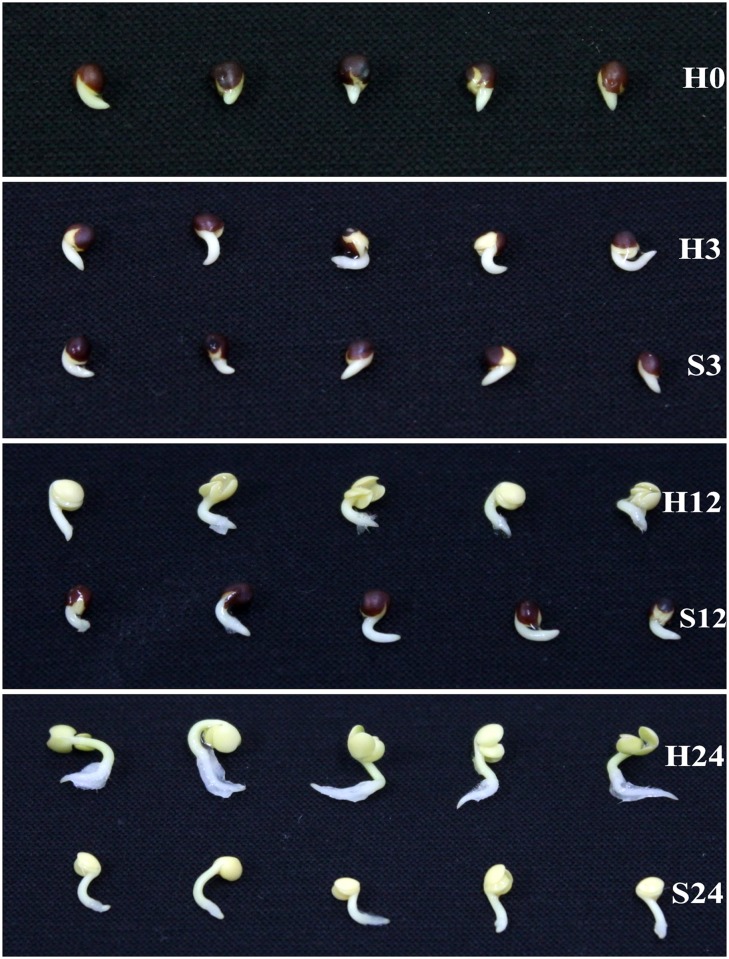
Phenotypes of germinated seeds of Brassica napus line WH126 at 0, 3, 12 and 24 hours after H2O (control) and salt (1.25% NaCl) treatments.The names on the figure refer to the corresponding rows of germinated seeds. H indicates H2O treatment, S indicates salt treatment and the adjacent numbers indicate the sampling time points. The names were also used to describe the corresponding cDNA libraries.